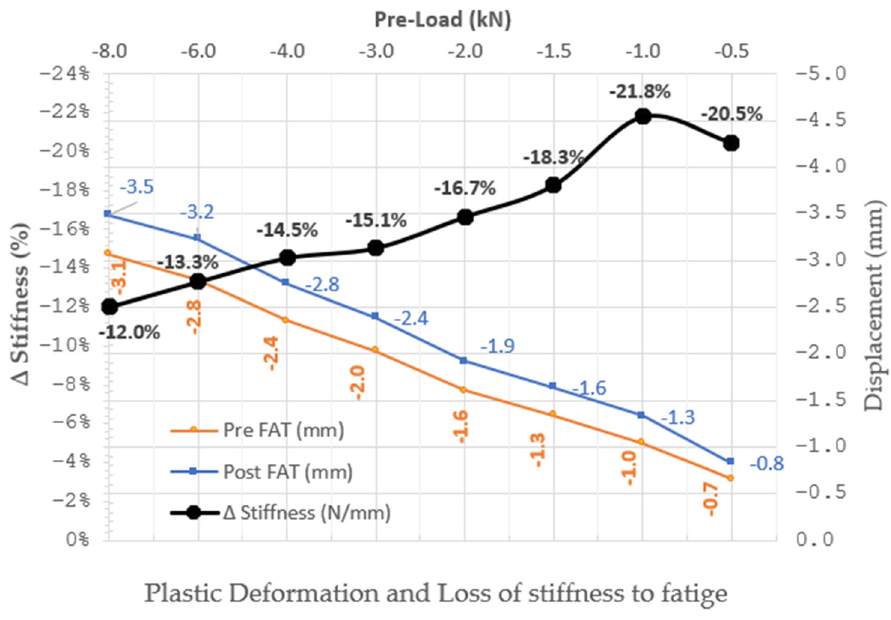
Figure 14. Fatigue Test Results.